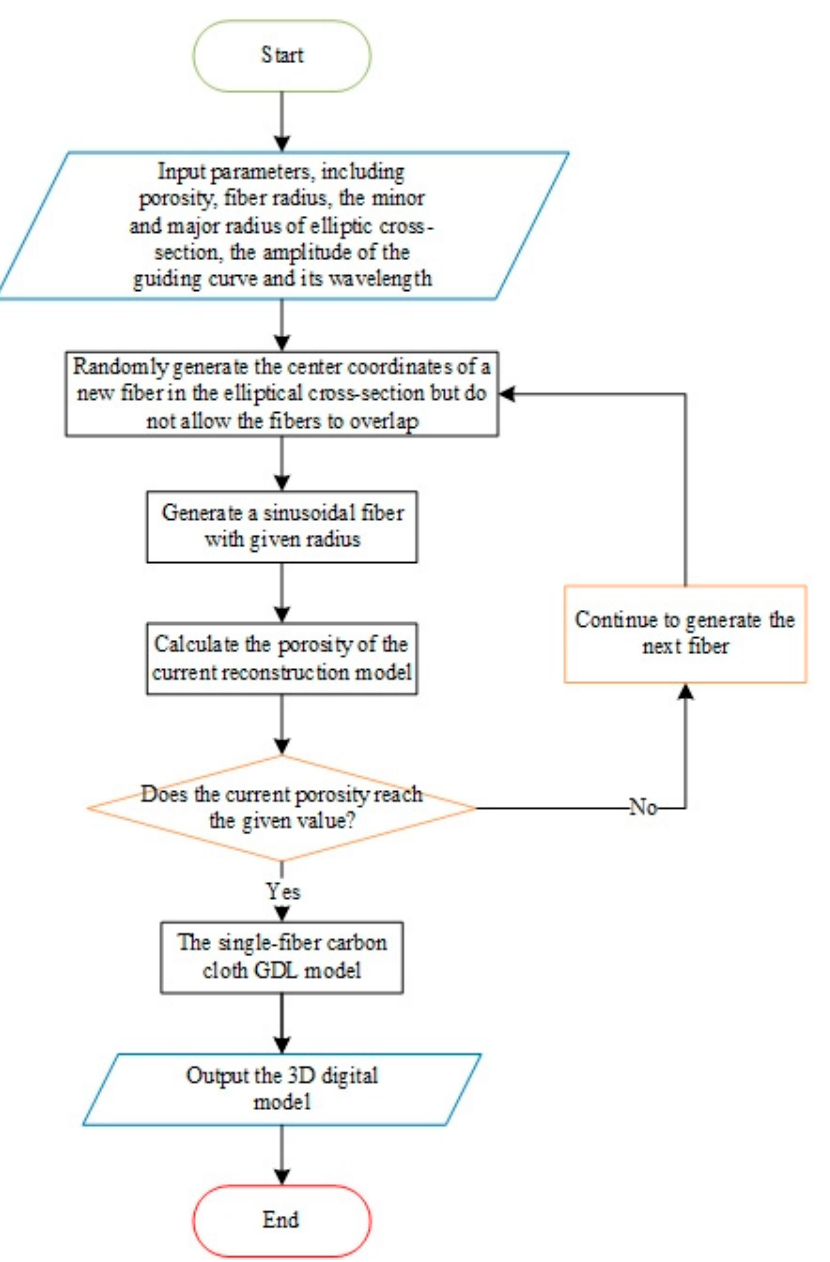
Figure 3. Flow chart of reconstruction process of the single fiber carbon cloth.